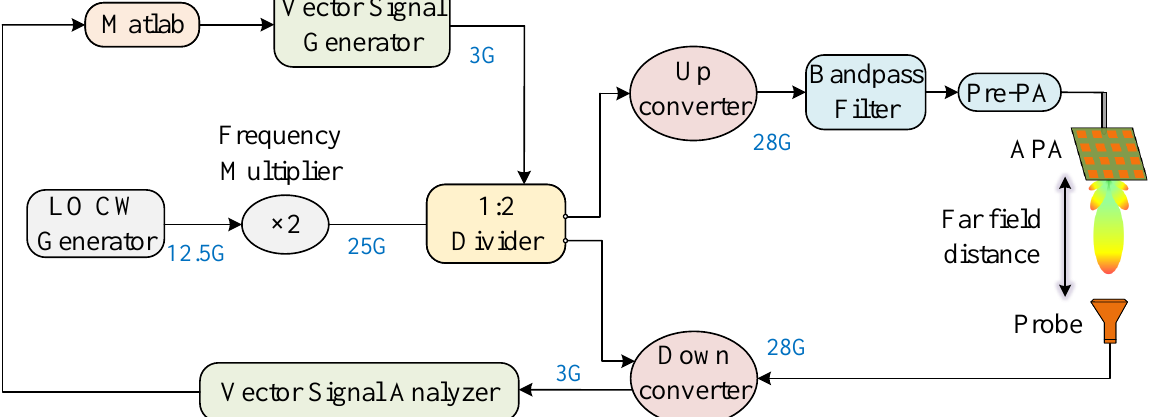
Figure 7. Schematic diagram of the experimental